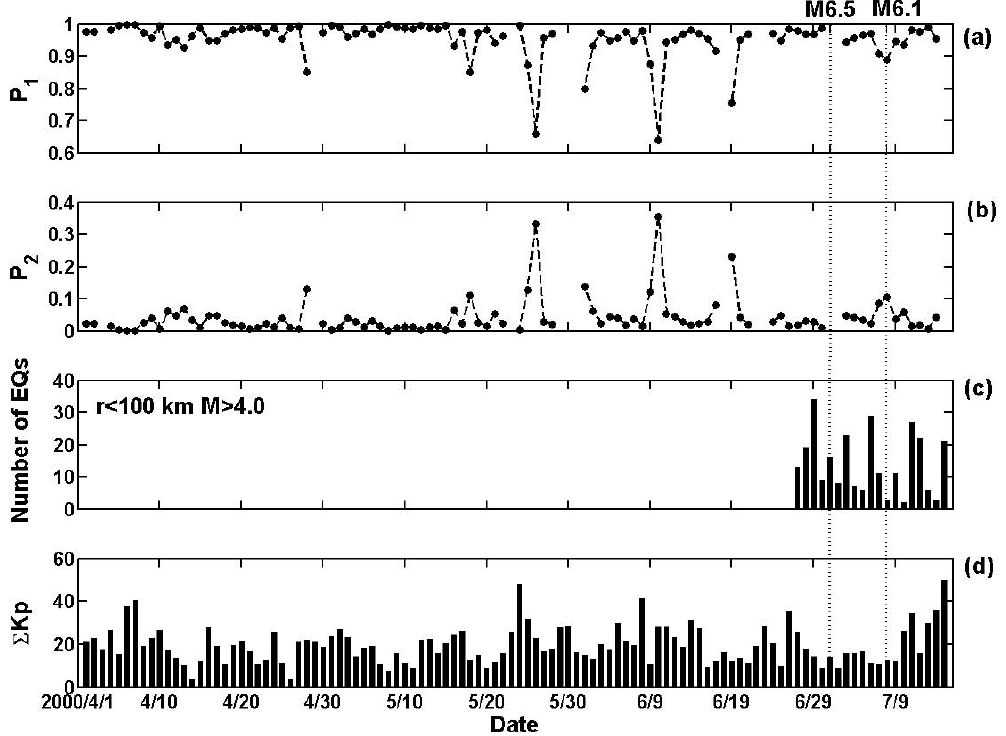
Fig. 5. Temporal variation of contribution (percentage) of each principle component to the geomagnetic diurnal variation, which is ob- tained by applying Principle Component Analysis (PCA) to the geomagnetic diurnal fitting data of X component of geomagnetic field at Seikoshi (SKS), Mochikoshi (MCK) and Kamo (KAM) stations. The number of earthquakes around the stations and the magnetic 6K p index are also given for reference. The vertical dashed lines indicate two M > 6.0 earthquakes in the investigated spatio-temporal range.